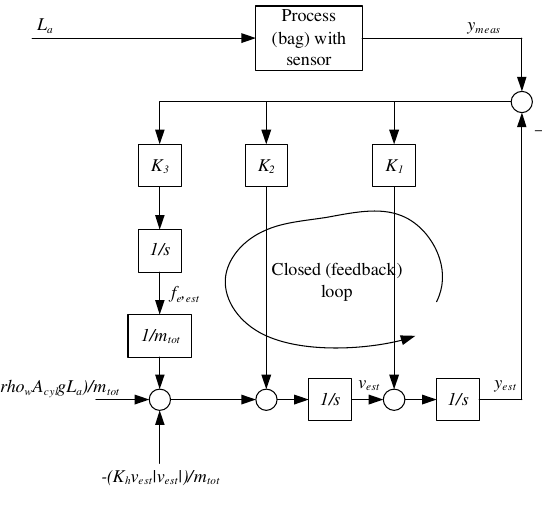
Figure 5: The observer which is used to estimate the environmental force f e . ( 1 /s is the transfer function of an